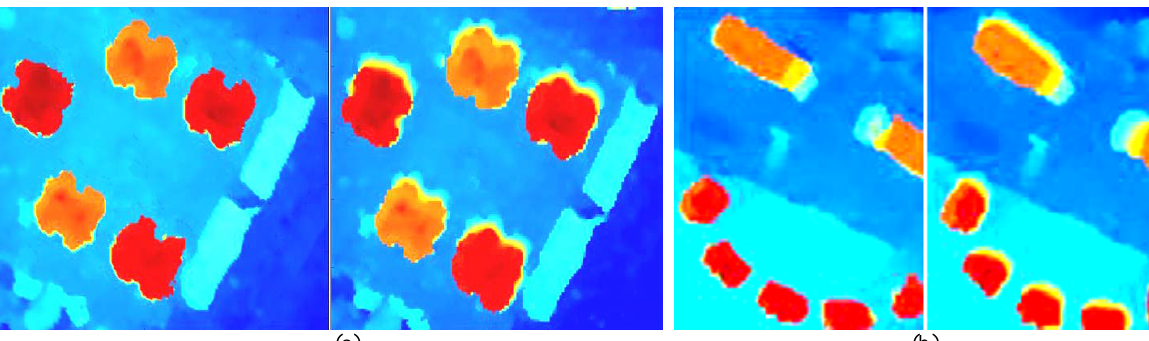
Figure 10. The visual comparison of our results- left in (a), (b) - with the given DSM- right in (a), (b) - for two different parts of